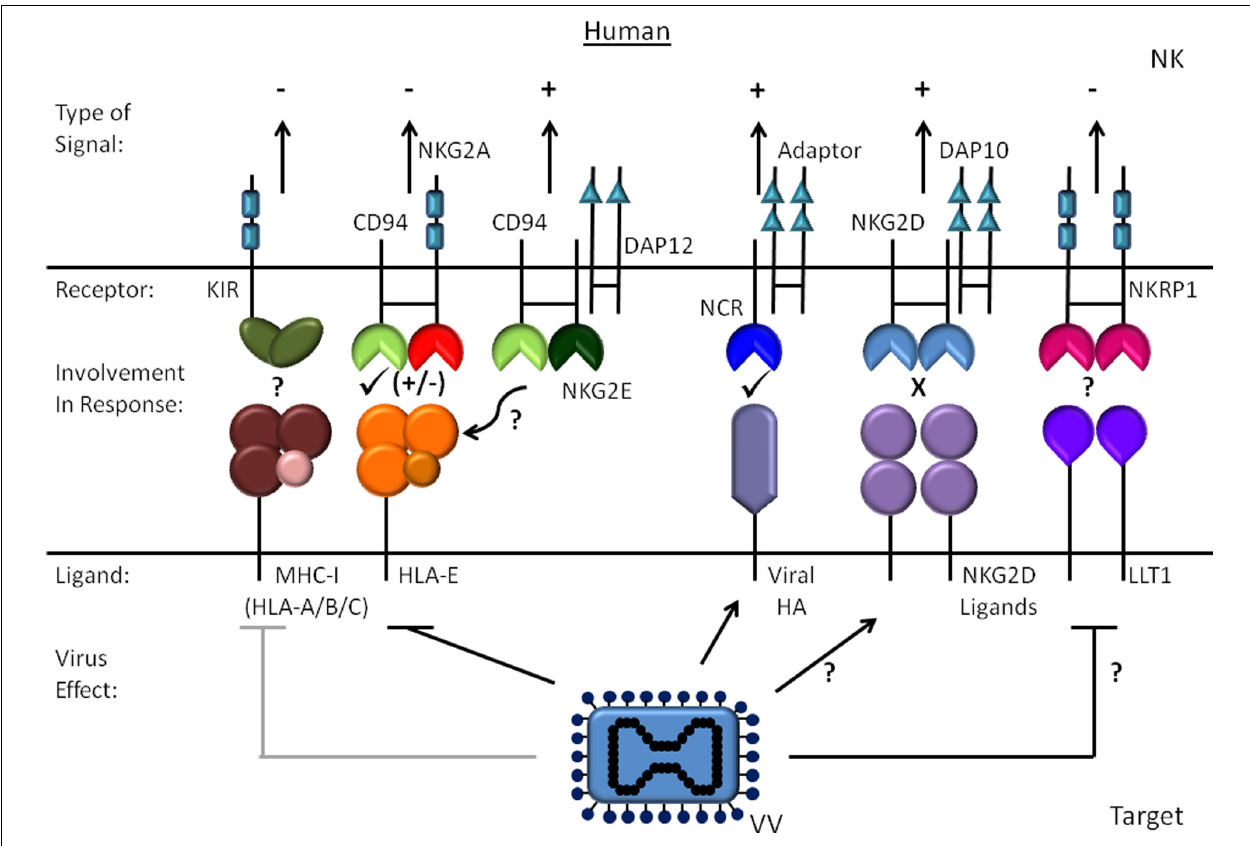
FIGURE 1 | Human NK cell recognition of vaccinia virus-infected cells. The activating and inhibitory human receptors and ligands are shown for vaccinia virus infection of human cells.The effect of infection on the ligands is indicated with an arrow for molecules that increase and a line to proteins that are reduced.